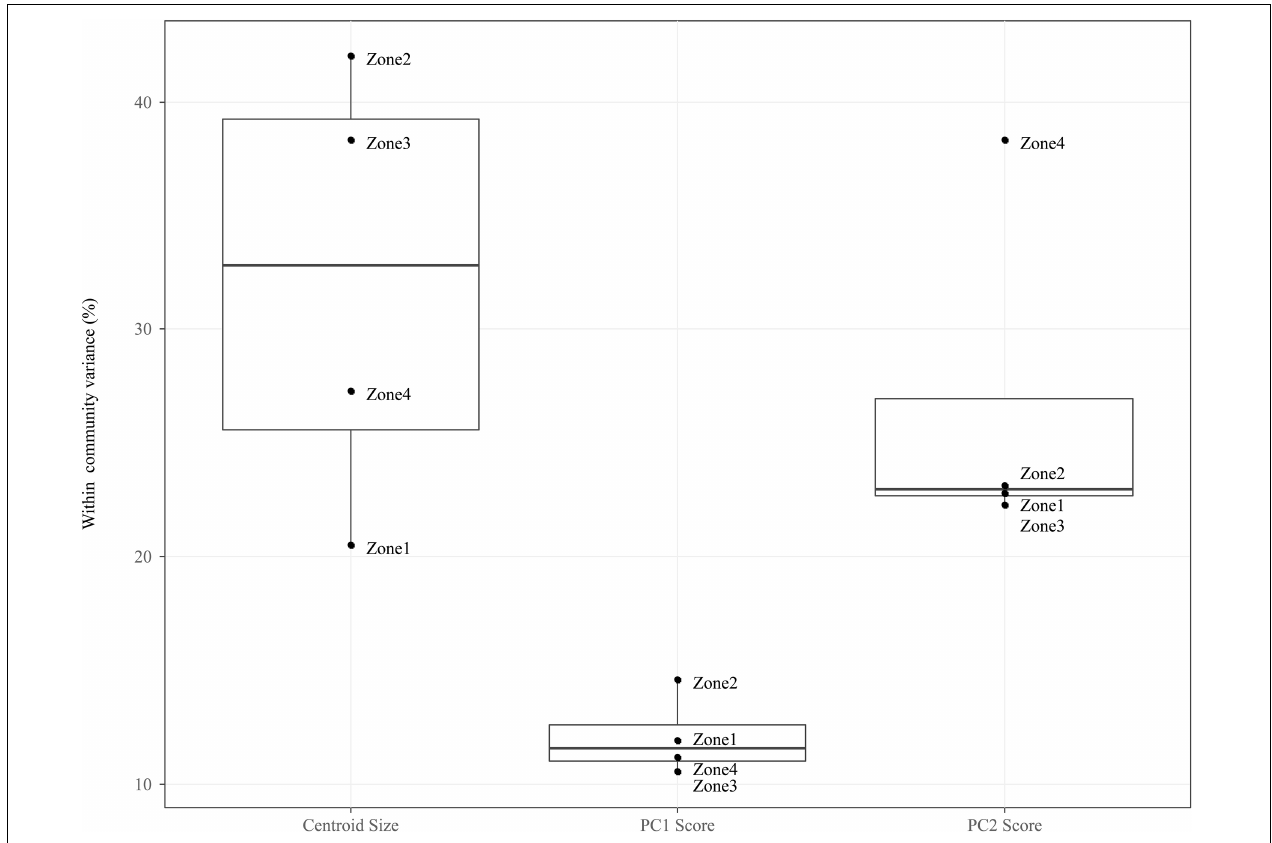
FIGURE 5 | Boxplots comparing the mean of within community (i.e., CONISS zones) intraspecific variance grouped by traits: Centroid size, PC1 Scores and PC2 scores. For each trait we measured the intraspecific variance for each species within a temporal community and took the mean value for all species.